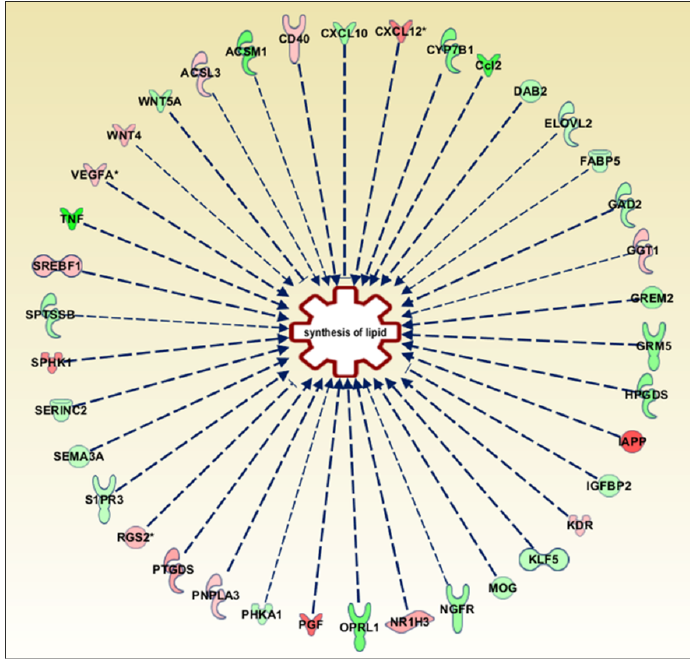
Figure 1. Ingenuity pathway analysis tool (IPA, Qiagen) was used to analyse dataset and explore the diseases and biological processes which are predicted to be increasing or decreasing based on the pattern of differentially expressed genes in the dataset. From this analysis we extrapolated the scheme in the Figure that includes the genes related to lipid synthesis differentially expressed in our dataset ( p -value = 9.67 × 10 − 4 ). The full names of these genes, together with the relative fold change (log2 ratio) are reported in Table S1. In red, upregulated genes; in green, downregulated genes.